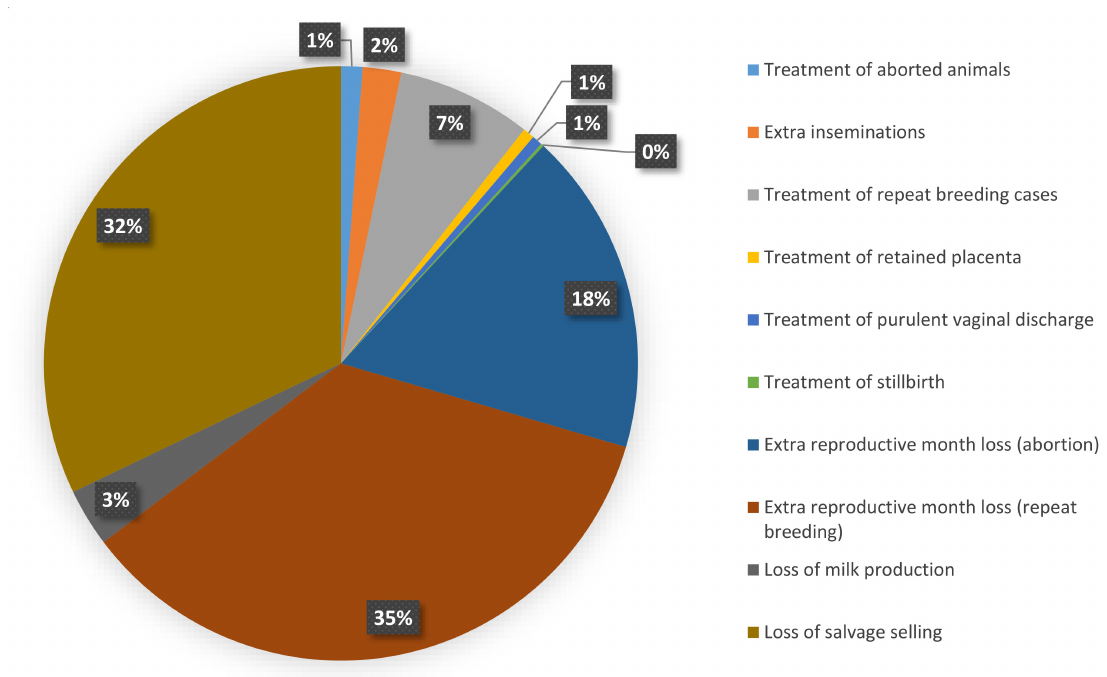
Figure 1. Distribution of different cost components to the total reproductive cost in Assam.